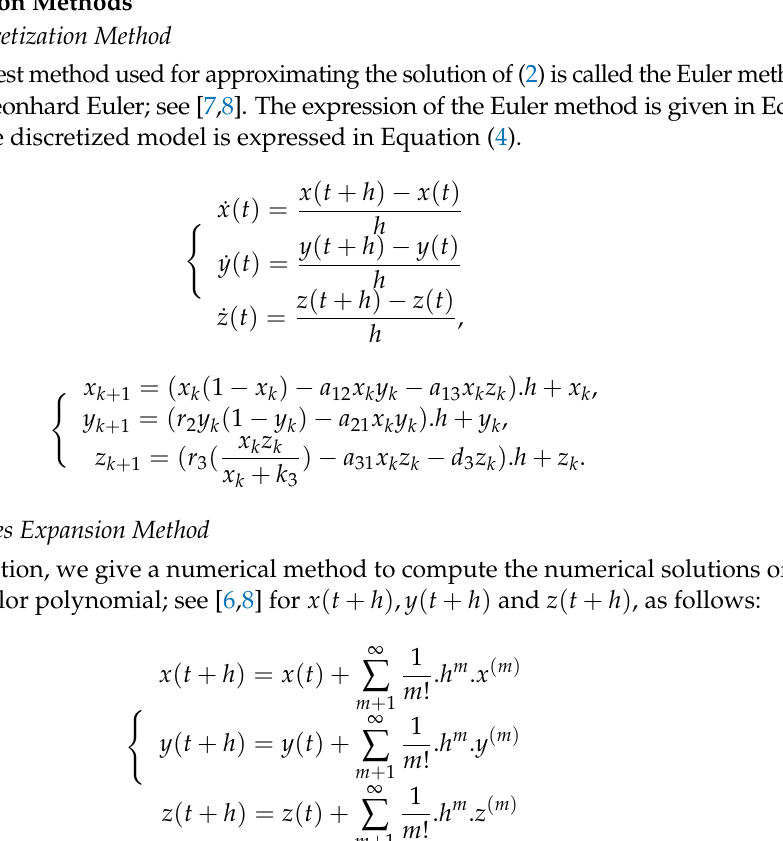
Figure 4. The Lyapunov exponents of system (2) with x 0 = 0.1, y 0 = 0.1, z 0 = 0.1 and parameter values r 2 = 0.6, r 3 = 4.5, a 12 = 1, a 21 = 1.5, a 13 = 2.5, a 31 = 0.2, d 3 =